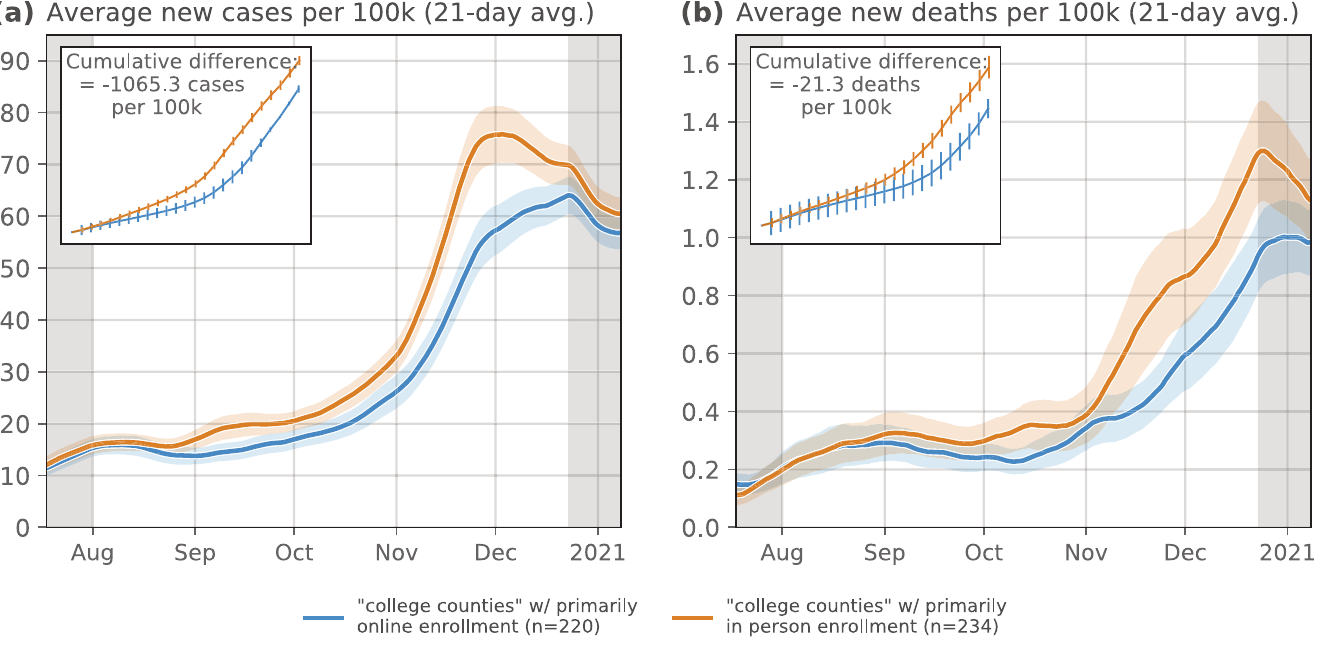
Fig 2. Counties with IHEs categorized as in-person vs. online for Fall 2020. Here, we compare the average (a) new cases and (b) new deaths per 100,000 in counties with IHEs that were categorized as “primarily in-person” vs. “primarily online” for the Fall 2020 semester. IHEs classified with “hybrid” reopening strategy were not included in this comparison as there is a great deal of heterogeneity in what constitutes a “hybrid” reopening. IHE reopening data is from [37]. (Ribbons: 95% confidence interval).